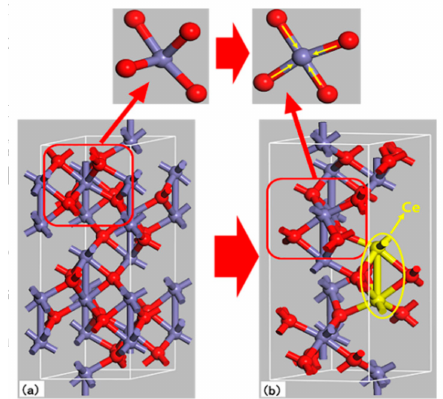
Figure 8. Unit cell of α -Fe 2 O 3 (purple ball is O; red ball is Fe; yellow ball is Ce). ( a ) Undoped α -Fe 2 O 3 sample; ( b ) Ce-doped α -Fe 2 O 3